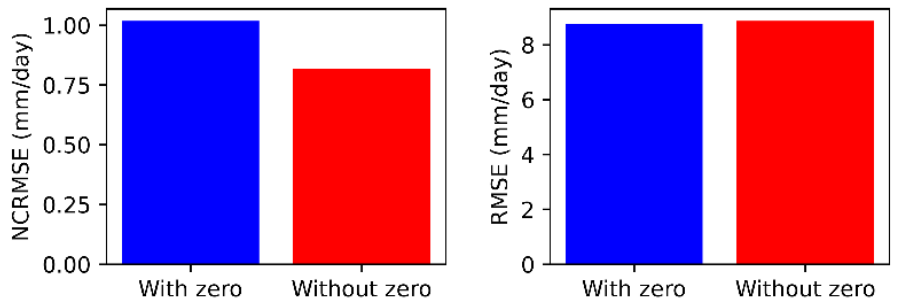
Figure 10. NCRMSE and RMSE for test datasets with (blue) and without (red) zero precipitation included.